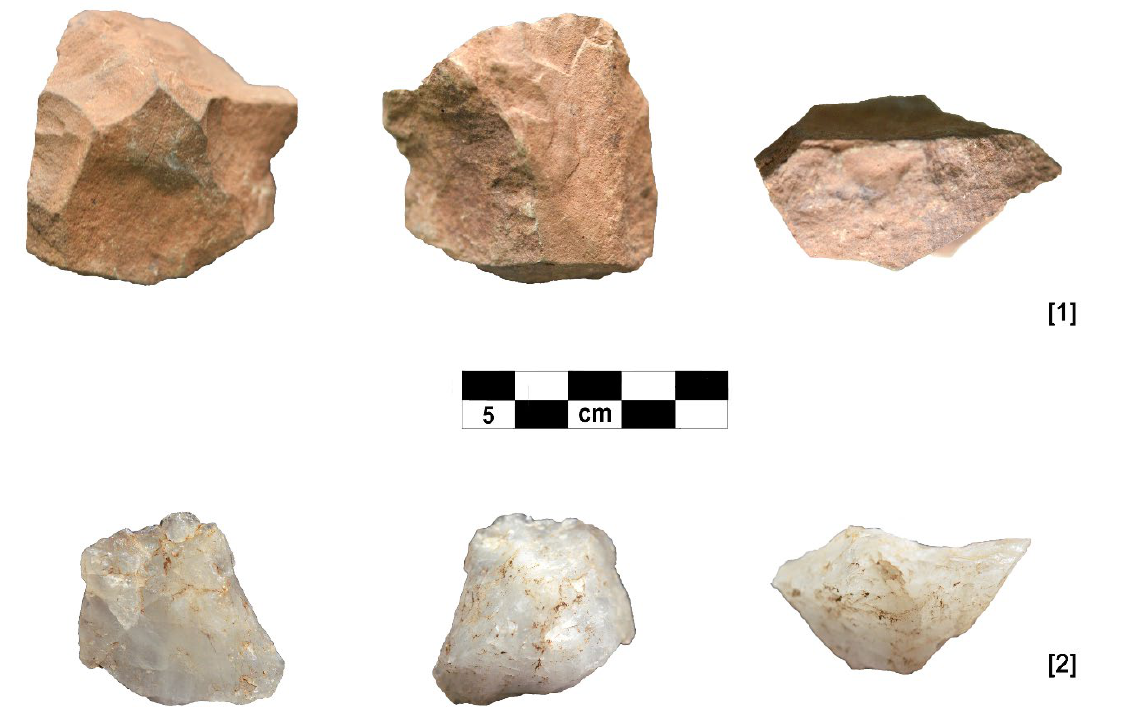
Figure 11. Quartz (base) and basalt cores (top) from the Gotera lithic collection: [1] irregular core with cortex; [2] Levallois centripetal